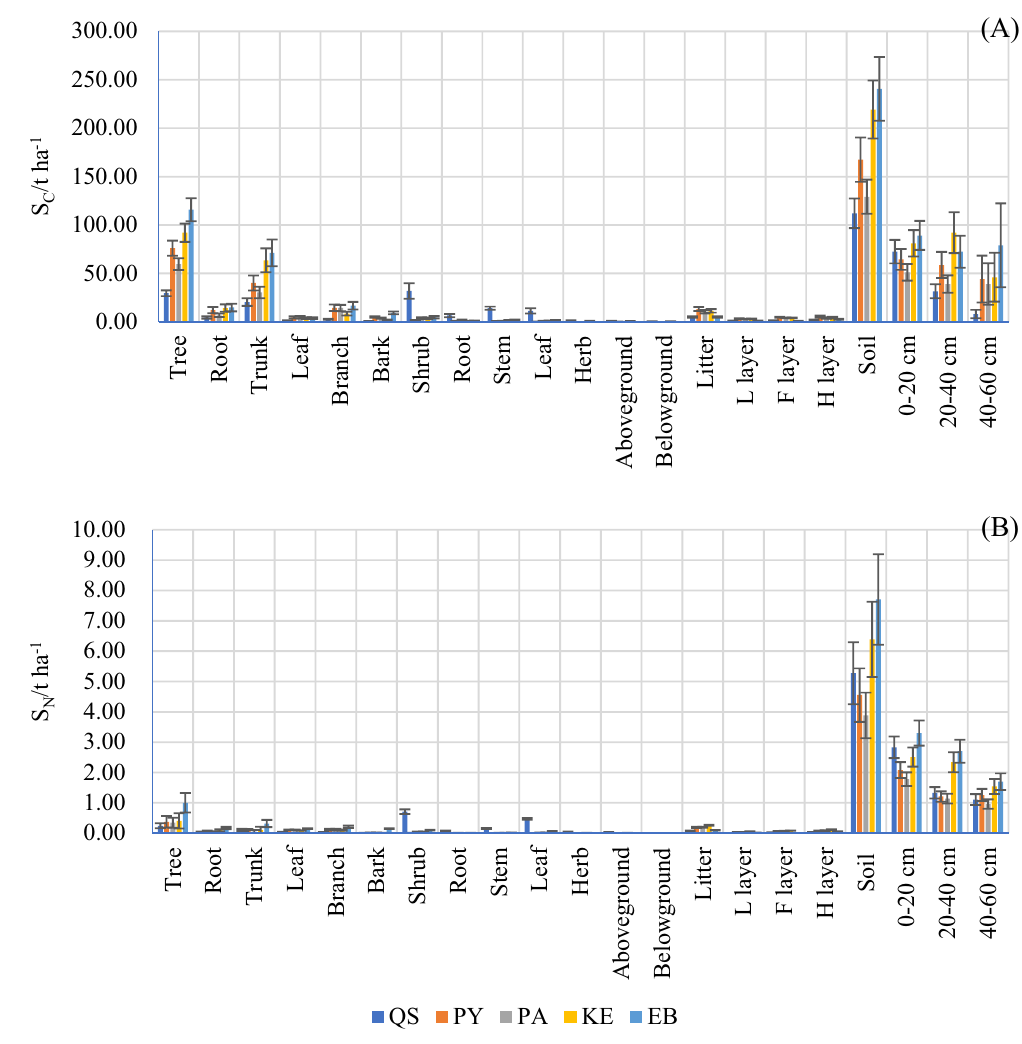
Figure 3. S C (t ha −1 ) and S N (t ha −1 ) storage allocation among the plant components, litter and soil layers in various forest types in the central Yunnan Plateau. Error bars mean standard